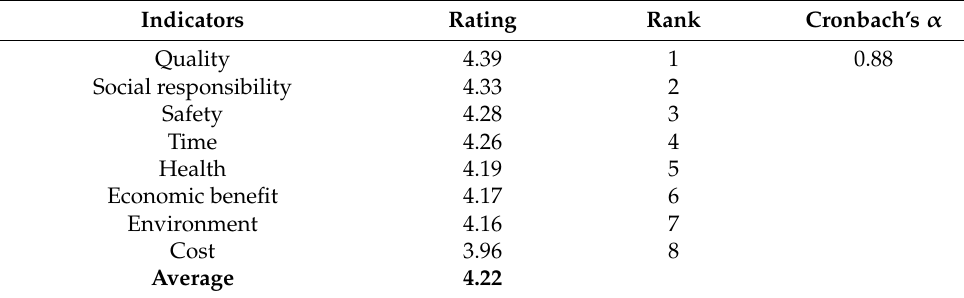
Table 5. EPC hydropower project performance. Indicators Rating